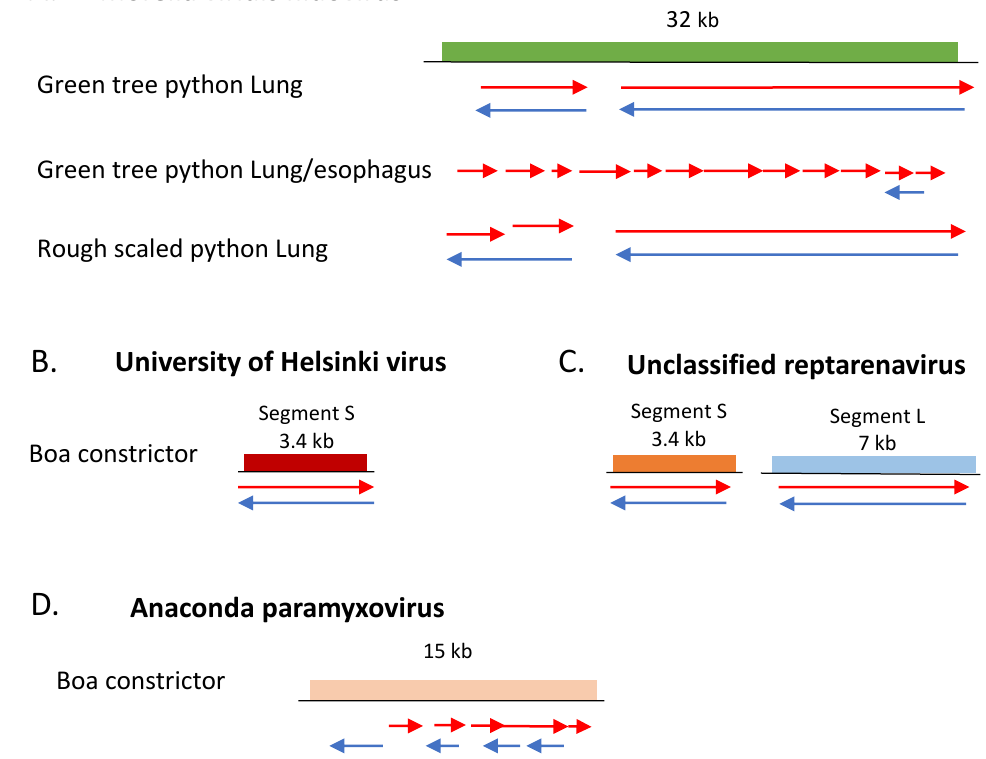
Figure 5. Snake dsRNA contigs aligned to viral genomes. Arrows indicate the relative location of nucleotide sequences in contigs assembled from dsRNA that align with the corresponding virus. Contigs representing the positive strand of the virus are in red. Contigs representing the negative strand in blue. Longest region of contiguous similarity is shown. Colored boxes represent protein coding regions. ( A ) dsRNA contigs isolated from green tree and rough scaled python lung and lung / esophagus pooled tissue mapped to the Morelia viridis nidovirus genome; ( B ) boa constrictor dsRNA contigs mapped to University of Helsinki reptarenavirus S segment; ( C ) representative boa constrictor dsRNA contigs that mapped to entire length of S and L segments of unidentified reptarenavirus strain reptarenavirus / boa constrictor / california / snake38 / 2009; ( D ) boa constrictor dsRNA contigs mapped to Anaconda paramyxovirus isolate